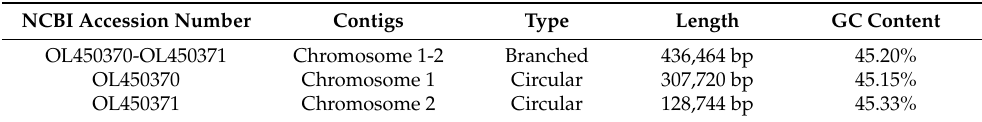
Figure 1. C. speciosa mitochondrial genome gene map. For both circular chromosomes, inner genes are transcribed clockwise and outer genes are transcribed counter-clockwise. Genes are color-coded, as indicated in the legend. Table 1. Basic information of C. speciosa mitochondrial